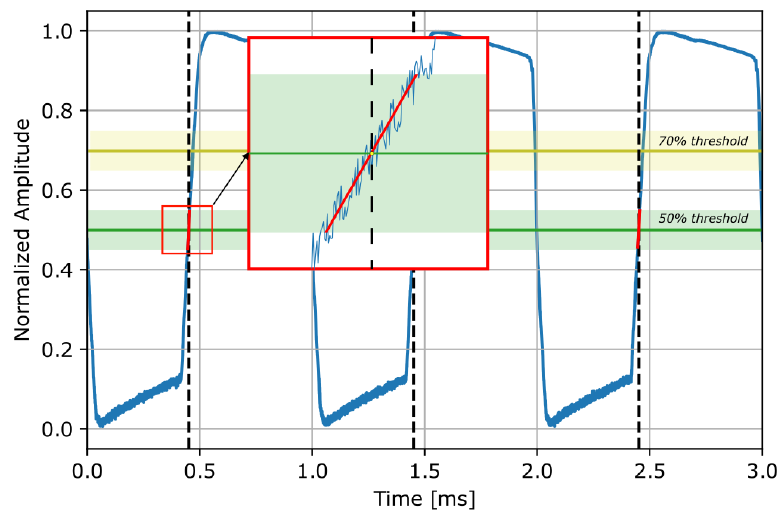
Figure 4. Threshold and interpolation process: example with 1 kHz wave frequency and 50% threshold